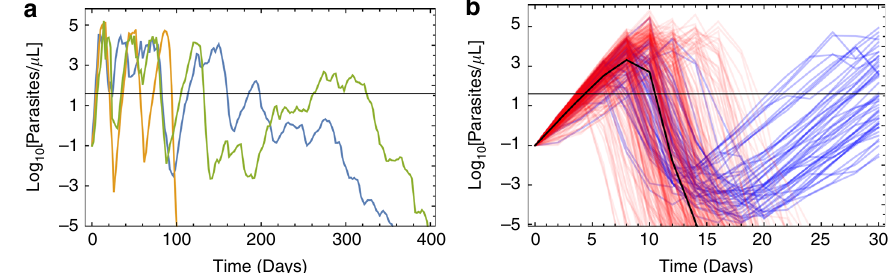
Fig. 1 Simulated parasitaemia within individual patients. Here we show example model output for the parasite density (the number of parasitised red blood cells per µ L) over time. Our within-host parasitaemia model was fi tting to data from 35 malaria therapy patients, as described in the ‘ Methods ’ and Supplementary Methods section. a Untreated infections, where each different coloured line represents a different patient. These three model simulations were selected to demonstrate the variety of infection duration generated by the model. b Treated infections in 1000 simulated patients treated with six doses of AL, with the median parasitaemia at each two-day time point shown in black. Treatment fails in about 5% of cases (here coloured blue),